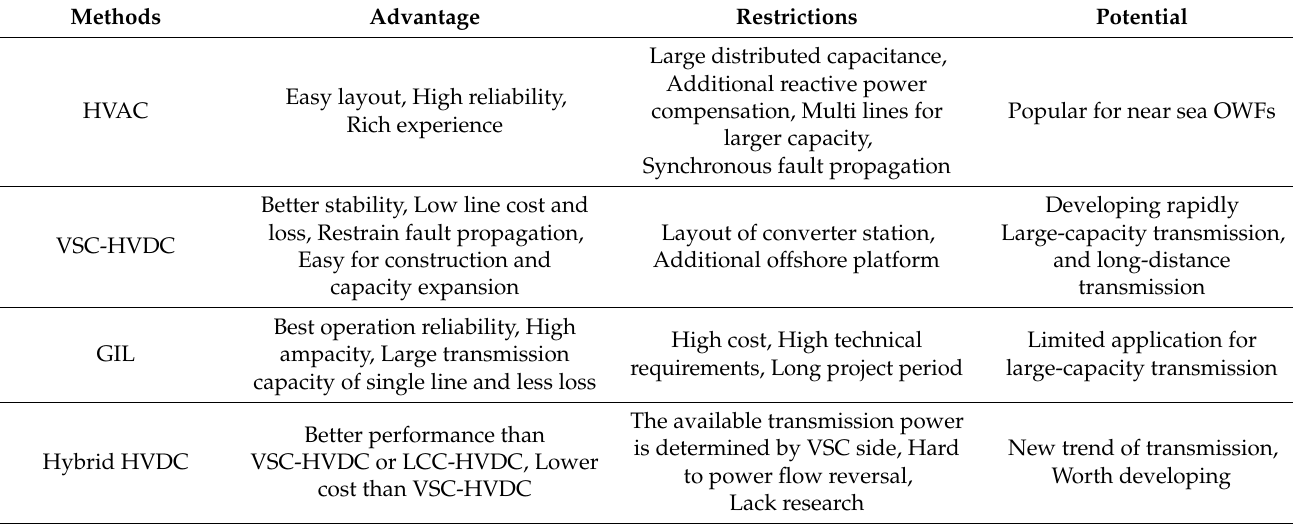
Table 1. Technical comparisons of the four transmission